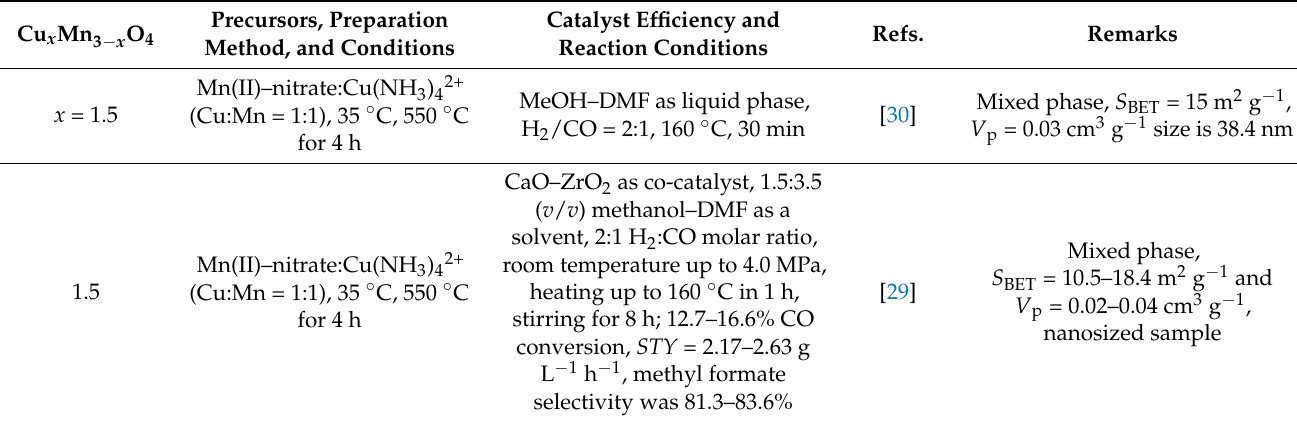
Table 11. Methyl formate synthesis from synthesis gas catalyzed by copper manganese oxide spinel containing